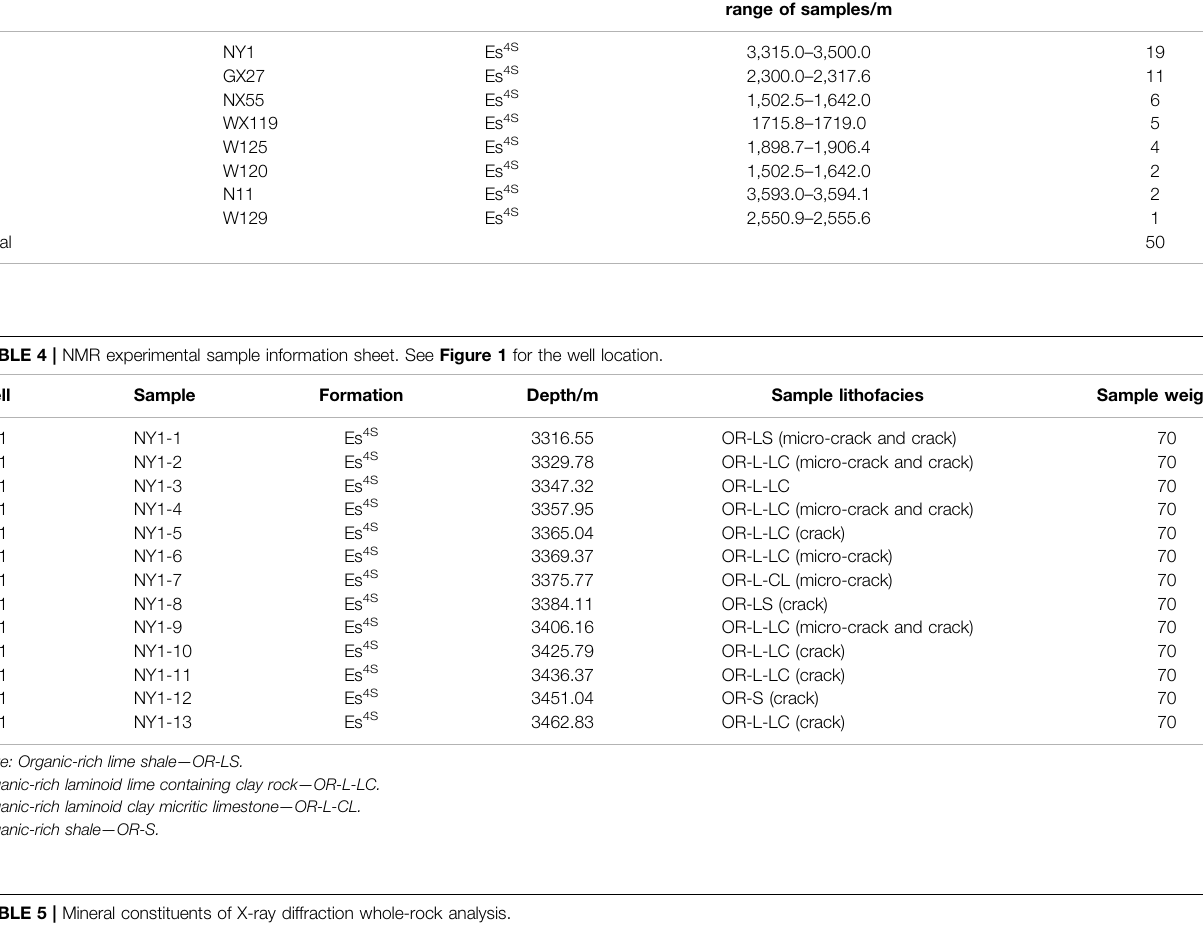
TABLE3| Thenumber,wellname,formation,depthrangeofsamples,andnumberofsamplesusedinX-raydiffraction(XRD)experiment.See Figure1 forthewelllocation. Number Well